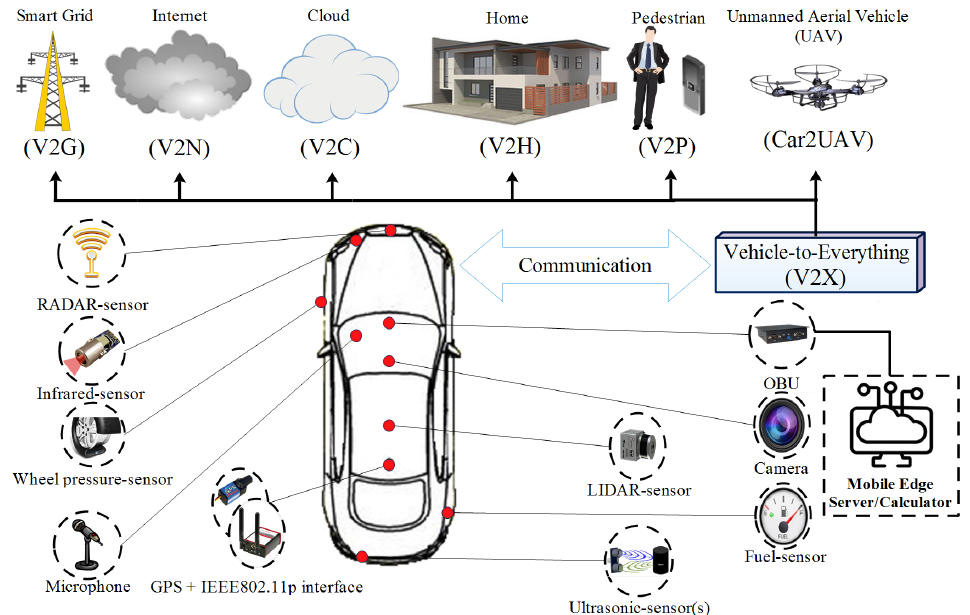
Figure 1. A conceptual illustration for the exploitation of embedded sensors in smart cars for environmental perception, the use of V2X technology for various communication types, and the deployment of OBU as a mobile edge server for IoV.